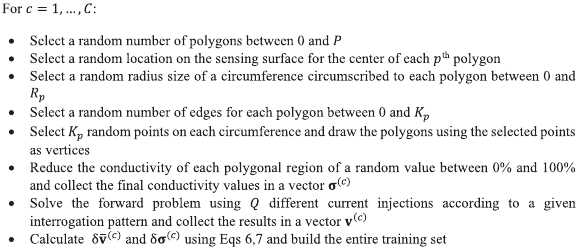
Algorithm 1: Construction of the training